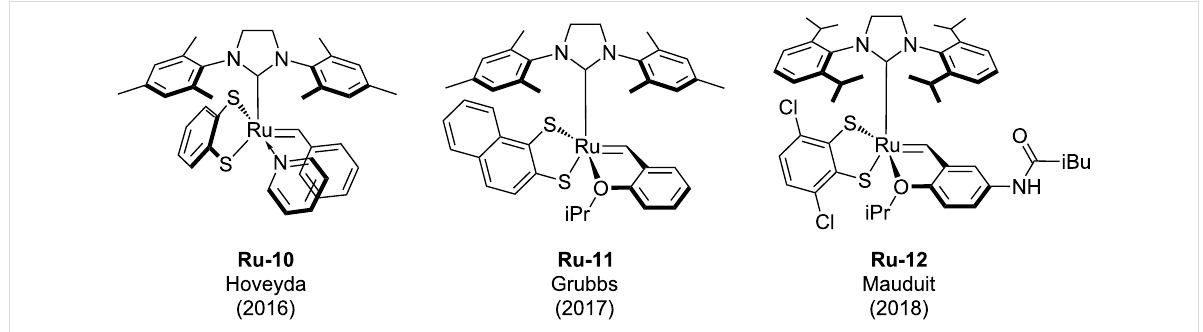
Figure 2: Selected examples of sterically or electronically modified ruthenium dithiolate